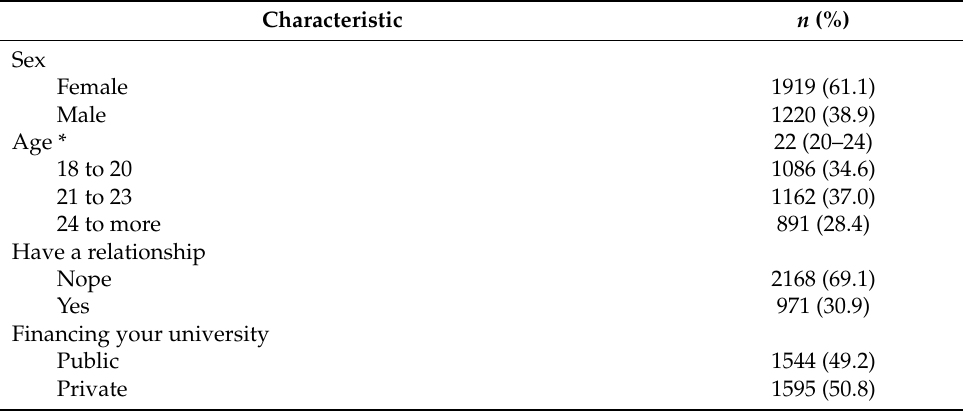
Table 1. Characteristics of the study population ( n =